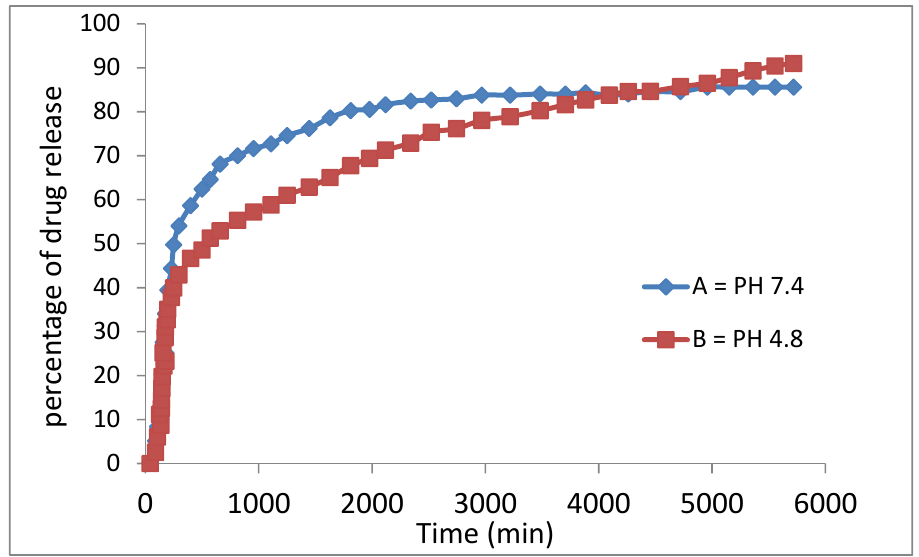
Figure 11. Release profiles of sorafenib from M-PEG–SO–ZLDH in phosphate-buffered solution at ( A ) pH 7.4 and ( B ) pH 4.8 .